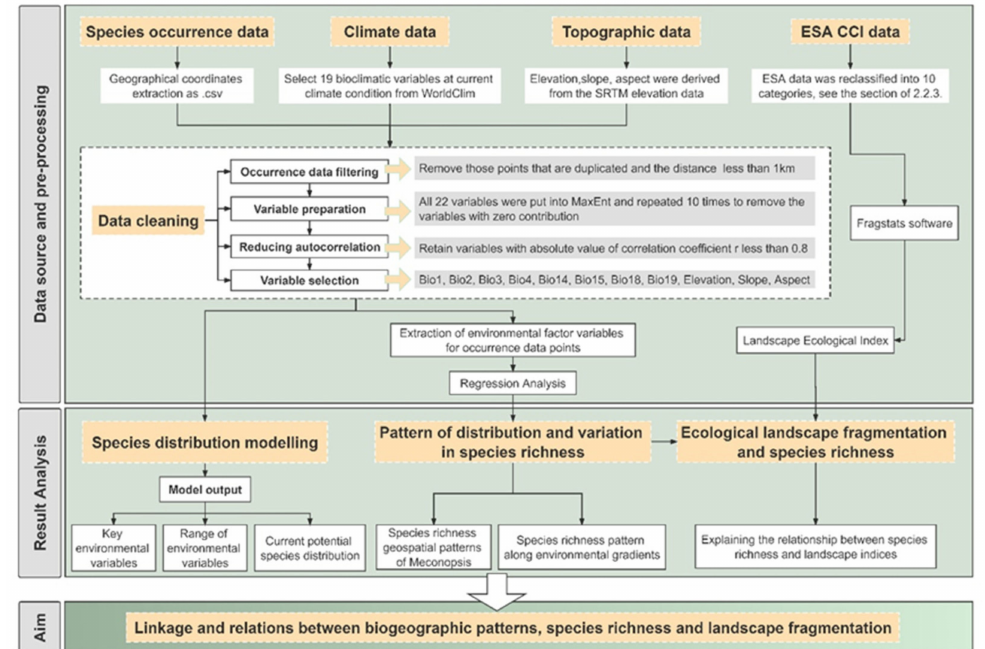
Figure 1. The conceptual framework of the